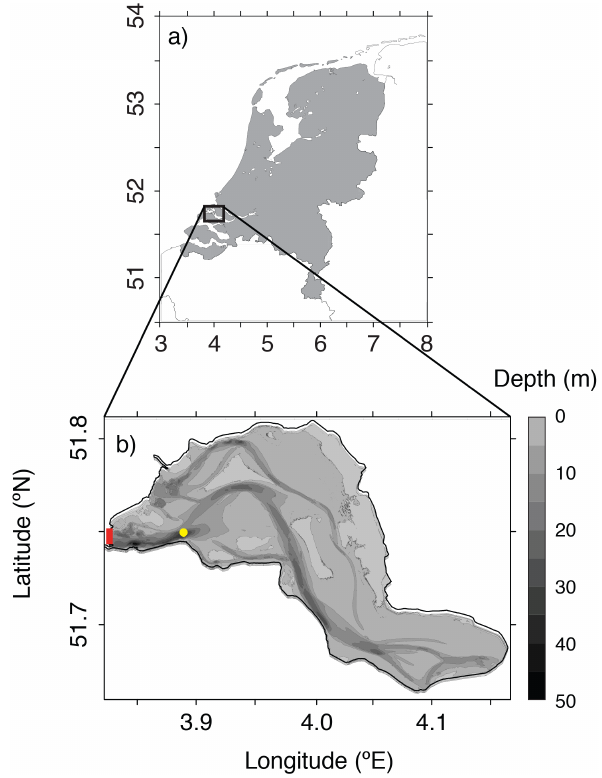
Figure 1. (a) Map of the Netherlands; (b) bathymetry of Lake Grev- elingen (data from the executive arm of the Dutch Ministry of In- frastructure and the Environment). Yellow dot indicates sampling location at the deepest point of the Den Osse basin (S1; 51.747 ◦ N, 3.890 ◦ E). Red bar indicates sluice location.